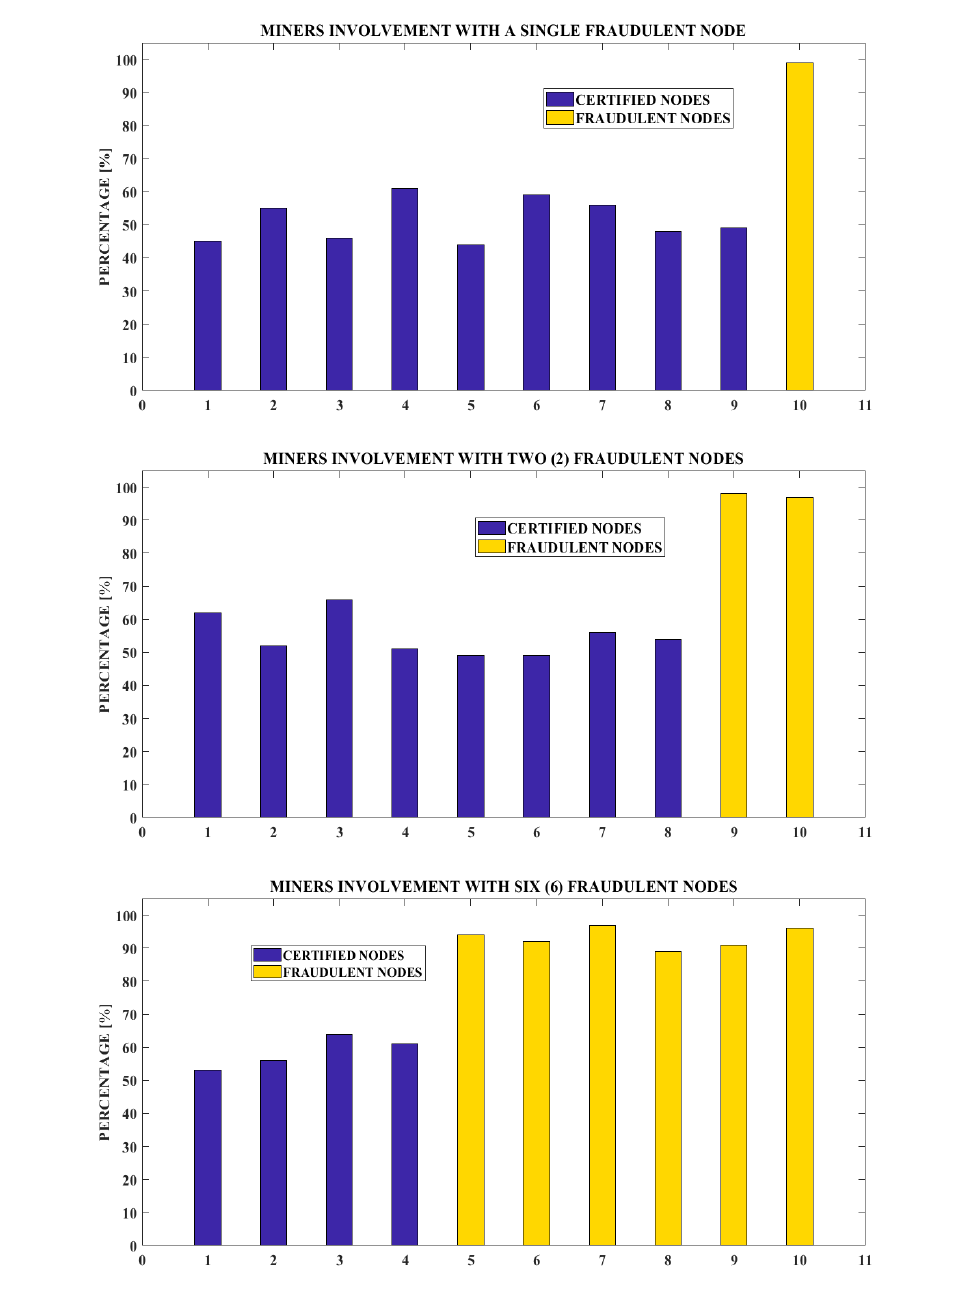
Figure 13. Miners involvement in forks using the proposed consensus